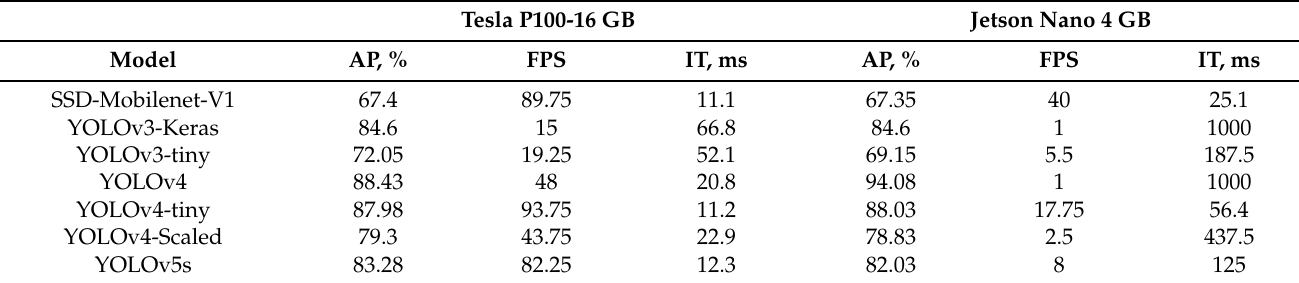
Table 6. Experimental results of investigated deep learning algorithm implementations for detection of capacitor, resistor, diode and transistor SMD